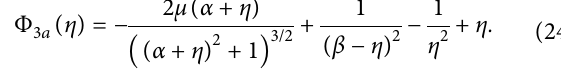
( α , β , ζ ) � 0 and Φ 2 a